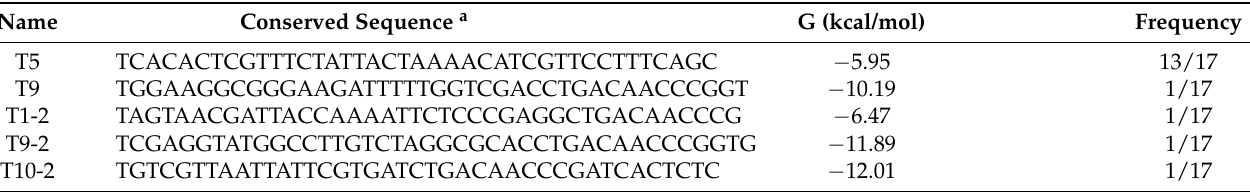
Table 2. Unique Tulane virus VPg aptamer sequences.